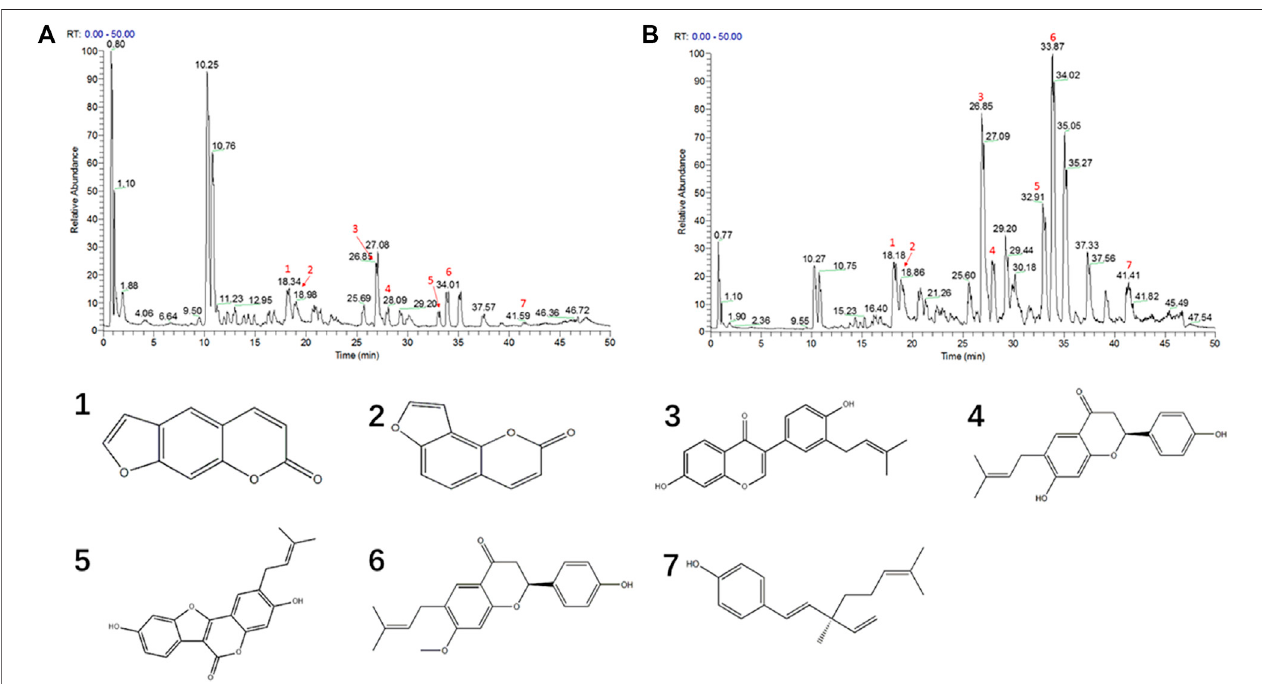
FIGURE 4 | The UHPLC-Q-Exactive MS chromatogram of PC granules. (A) The PFW positive ion mode diagram. (B) The PFE positive ion mode diagram. (C) Different compound structures. 1, psoralen; 2, isopsoralen; 3, neobavaiso fl avone; 4, bavachin; 5, psoralidin; 6, bavachinin; 7, bakuchiol.